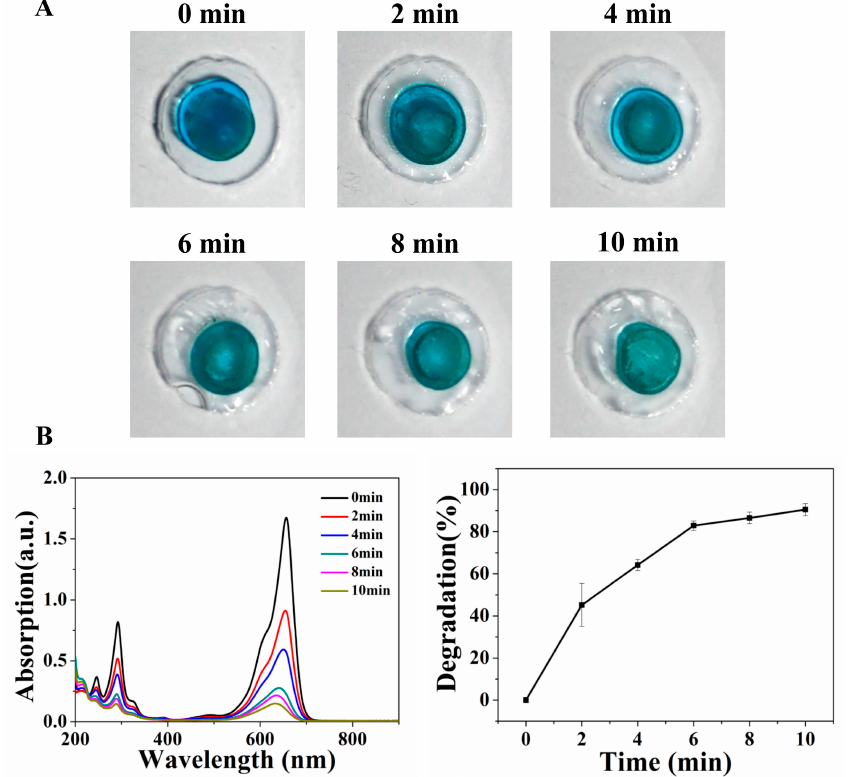
Figure 2. Degradation results of the coffee ring drop reactor method. ( A ) The blue color became gradually lighter as illumination time increased (0–10 min). ( B ) UV-vis spectra of the MB solution after illumination, and the corresponding degradation rates. Each test was repeated three times.